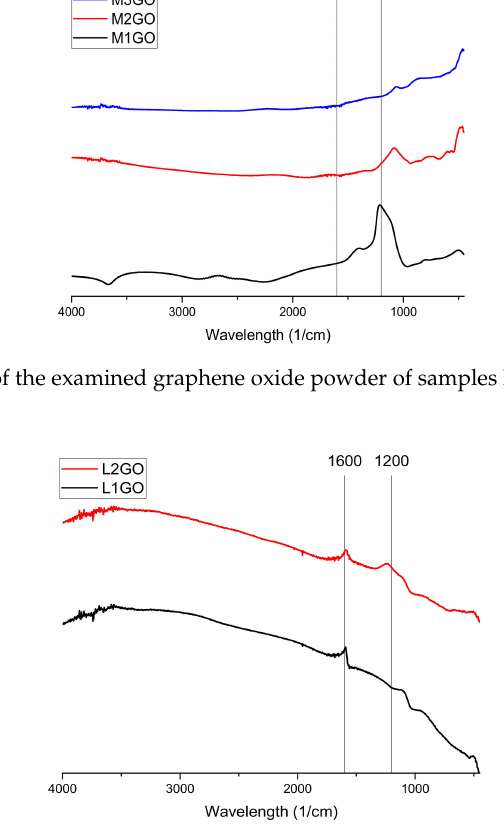
Figure 4. FTIR spectra of the examined graphene oxide powder of samples L 1 GO and L 2 GO as shown in Table